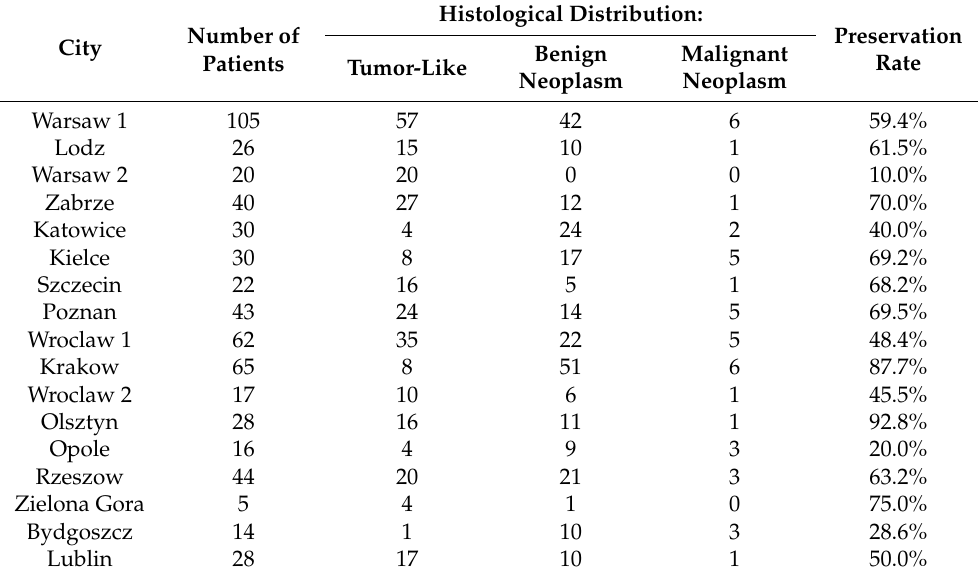
Table 1. Characteristics of each surgical center.